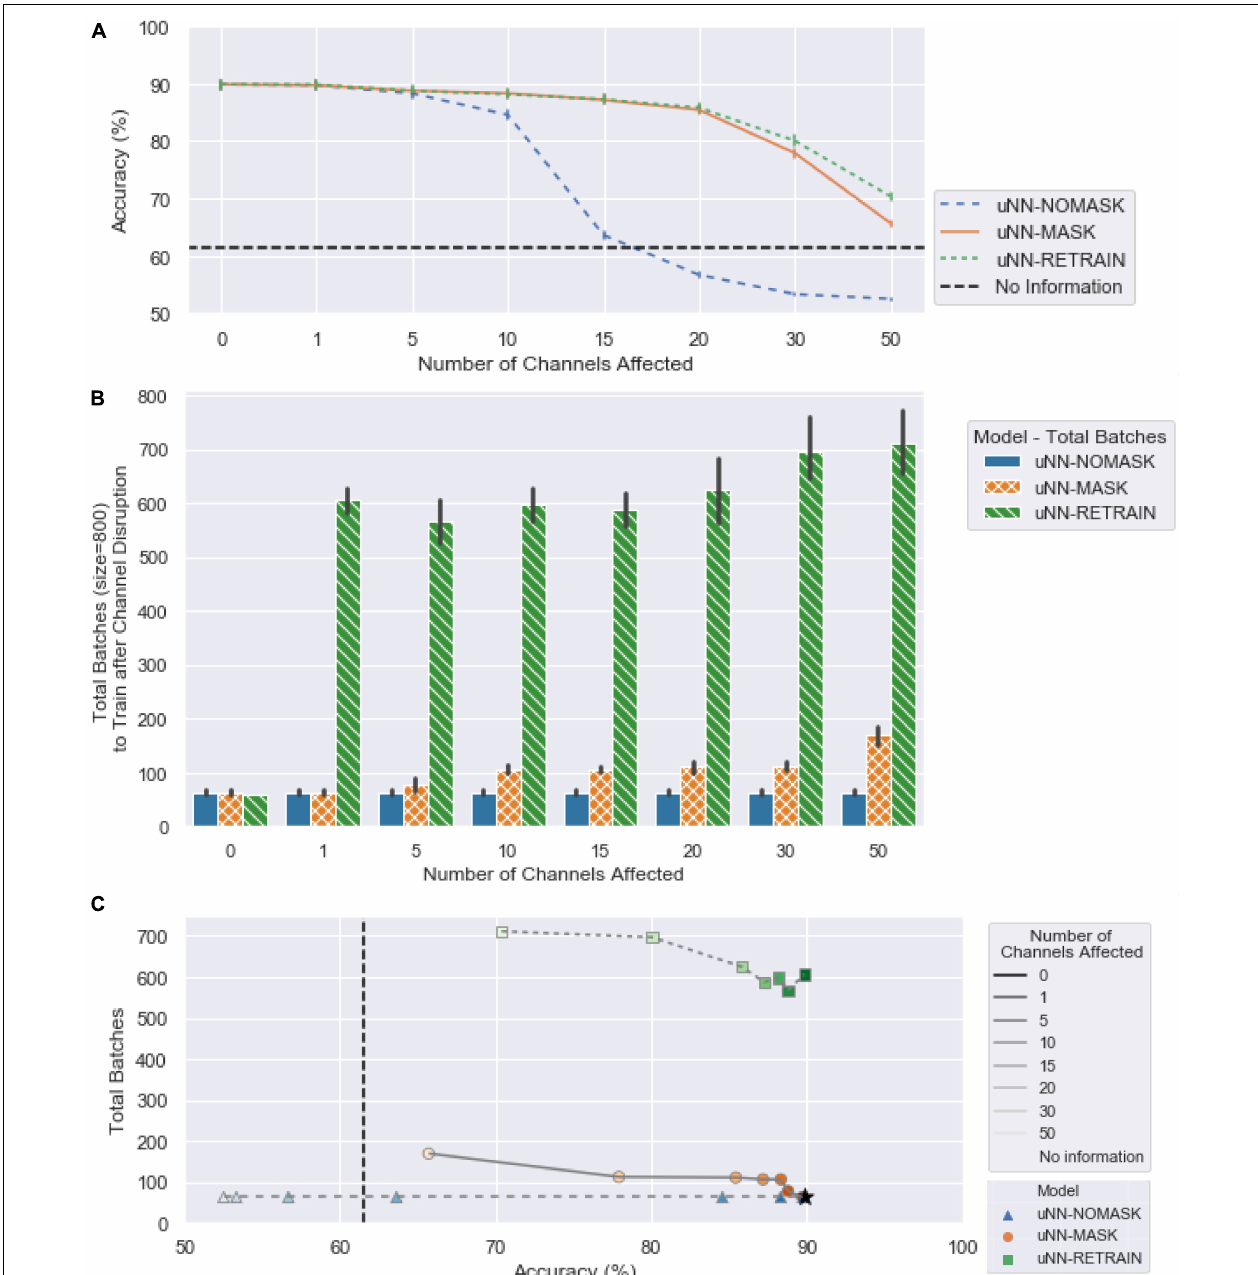
FIGURE 4 | (A) The mean accuracy for the three uNN decoders, replotted from Figure 3B with x -axis ticks realigned to match (B) . (B) The computational requirements of the uNN decoders as measured by the number of batches required for training after disruptions are introduced. When zero channels are affected, no masking or retraining takes place, and the model would only receive unsupervised updates. The number of batches required is according to an early stopping criterion and is averaged over each of the 10 random initializations applied. Error bars represent 95% confidence intervals. (C) The number of batches required as a function of decoder